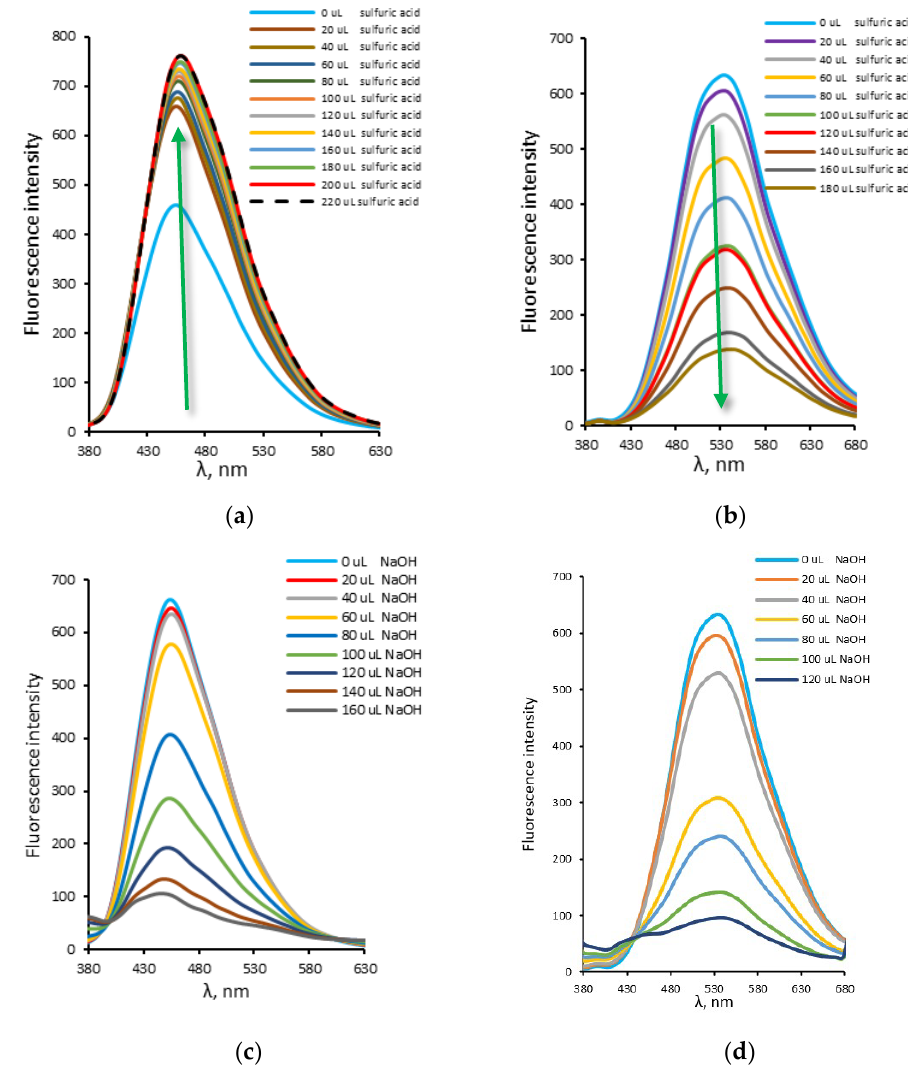
Figure 7. Fluorescence intensity in acetonitrile according to the pH: ( a ) coumarin 3a (c = 10 −5 M) behavior in sulfuric acid, 1N; ( b ) coumarin 3c (c = 10 −5 M) behavior in sulfuric acid, 1N; ( c ) coumarin 3a (c = 10 −5 M) behavior in NaOH, 1N; ( d ) coumarin 3c (c = 10 −5 M) behavior in NaOH, 1N . The green arrow is showing the changing of the fluorescence intensity depending on the H + concentration.